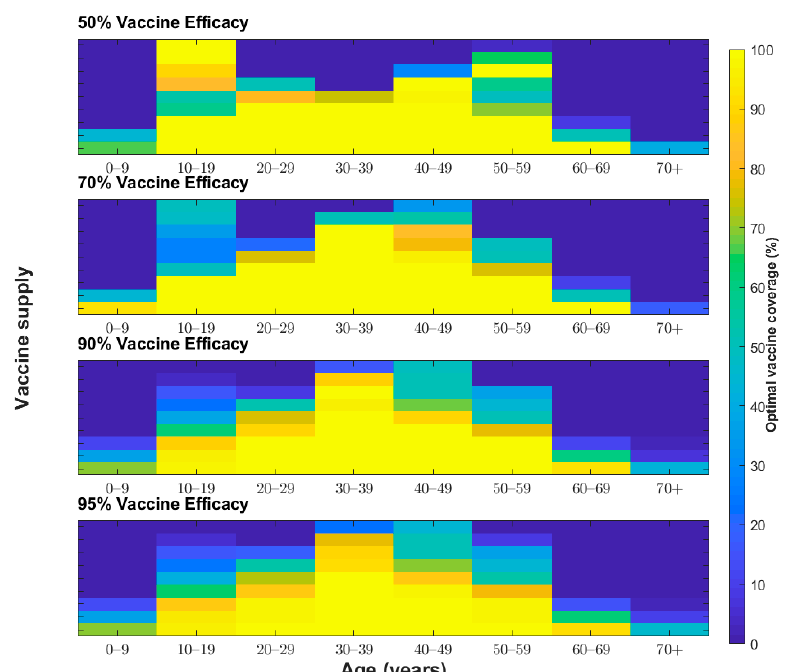
Figure 4. Proportion of individuals vaccinated from each age group ( x -axis) to minimize the total number of infections under various vaccine coverage levels ( y -axis) and vaccine efficacies (50%, 70%, 90%, and 95%).